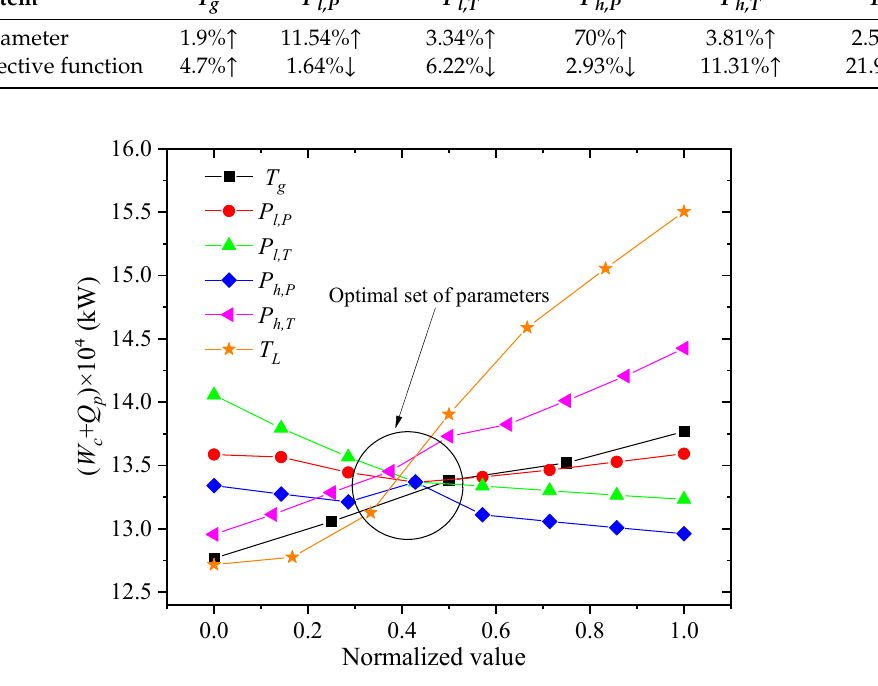
Figure 12. Relationship between the change of each parameter and the objective function. Table 5. Influence of each parameter change on the objective function.